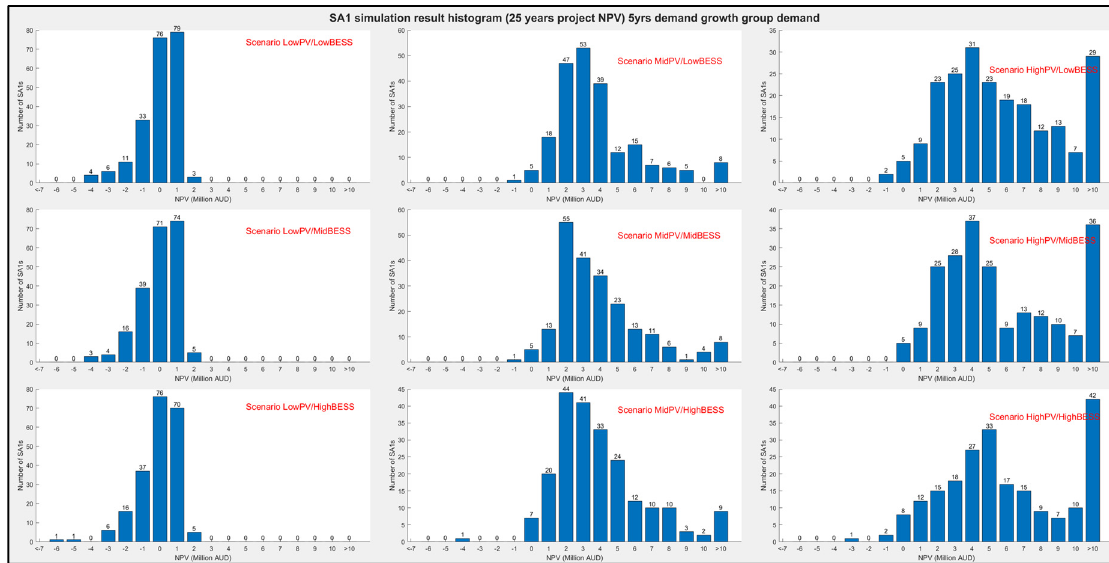
Figure 9. Histogram plots of SA1 simulation results for 25 years NPV.